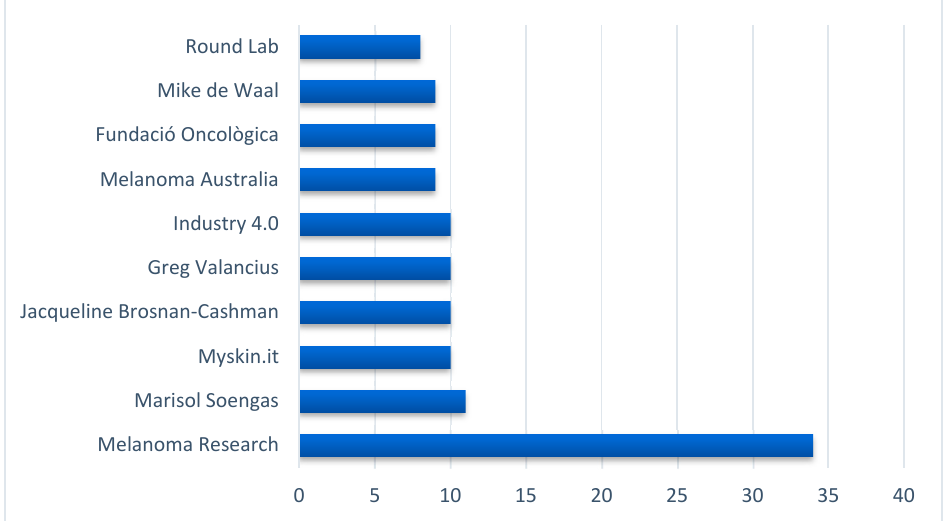
Figure 4. Top disseminators of melanoma-related information on Twitter ranked by the out-degree centrality scores.